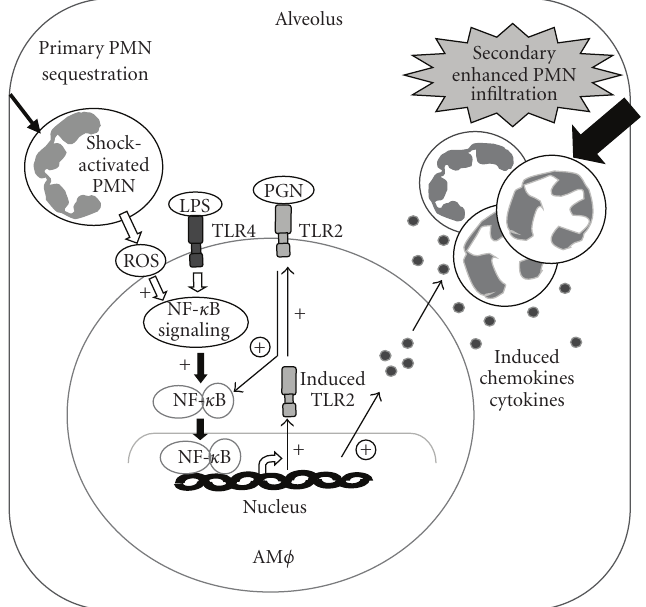
Figure 2: Model of shock-activated PMN in mediating the TLR4-TLR2 cross talk in AM φ and AM φ priming. Hemorrhagic shock- activated PMNs primarily migrate into alveoli in response to a trivial inflammatory stimulus, such as LPS, and interact with AM φ . The interaction between PMN and AM φ enhances LPS-induced TLR2 expression (+) in the AM φ , possibly mediated by PMNs-derived oxidants and augmented NF- κ B activation. The increased TLR2 expression results in the amplified response of AM φ to the TLR2 agonist (PGN), thereby augmenting cytokines and chemokines expression (circled +) and promoting enhanced PMN transalveolar migration. Thus, the shock-activated PMN-mediated TLR4-TLR2 cross talk activates a positive feedback signal leading to AM φ priming and exaggerated lung inflammation in response to invading